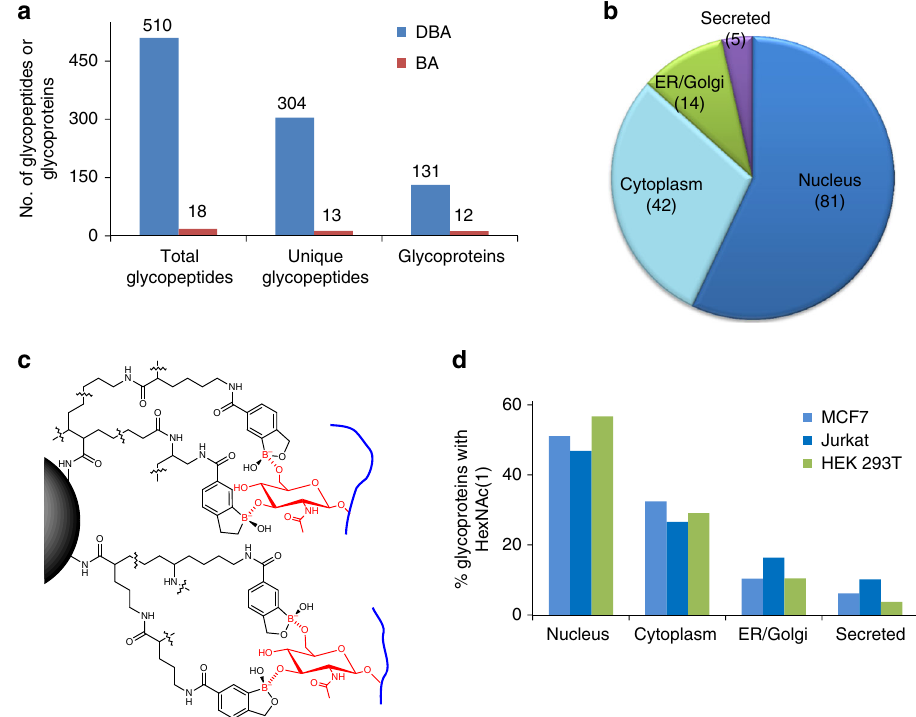
Fig. 6 The synergistic interactions dramatically enhanced the enrichment of O -GlcNAcylated peptides in human cells. a Comparison of glycoproteins with one HexNAc identi fi ed with BA and DBA, which clearly shows that the results from DBA are substantially better. b Distribution of O -glycoproteins modi fi ed with HexNAc(1) identi fi ed in HEK 293T cells based on the cellular compartment. c Proposed mechanism of the interactions between DBA and GlcNAc bene fi ting from synergistic interactions. d Cellular compartment distributions of glycoproteins containing one HexNAc identi fi ed in the three types of human cells (light blue — MCF7, dark blue — Jurkat, and green — HEK